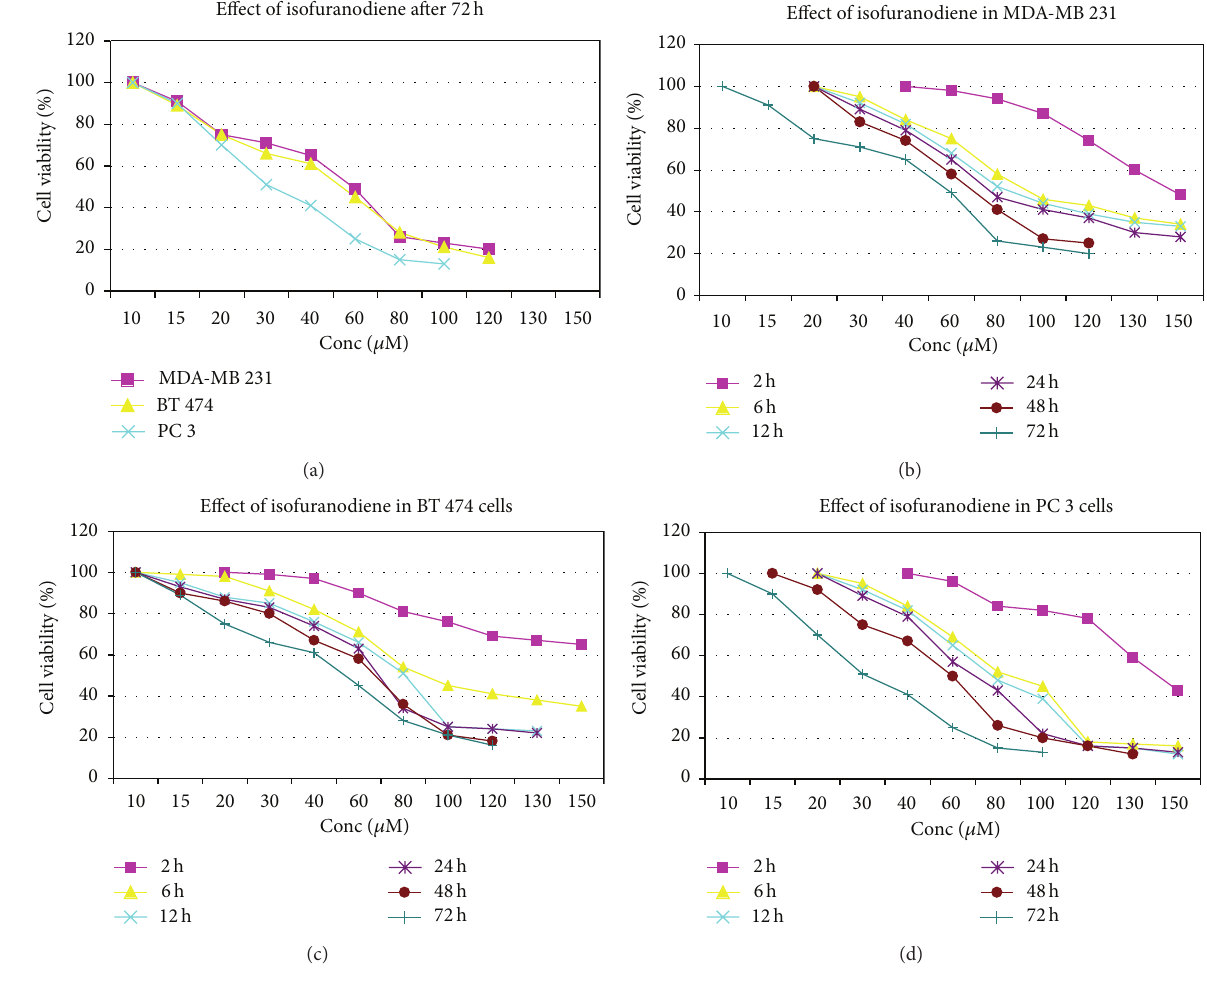
Figure 3: Cell viability in MDA-MB 231, BT 474, and PC 3 cell lines. (a) Percentage of cell viability after treatment with isofuranodiene at doses of 10–150 𝜇 M after 72 h of incubation. (b), (c), and (d) Percentage of cell viability after treatment with isofuranodiene at doses of 10–150 𝜇 M at different incubation times (2, 6, 12, 24, 48, and 72 h). The results are reported as (viability of treated cells)/(viability of control cells) × 100 and represent the average of three independent experiments with a maximum SD lower than ±